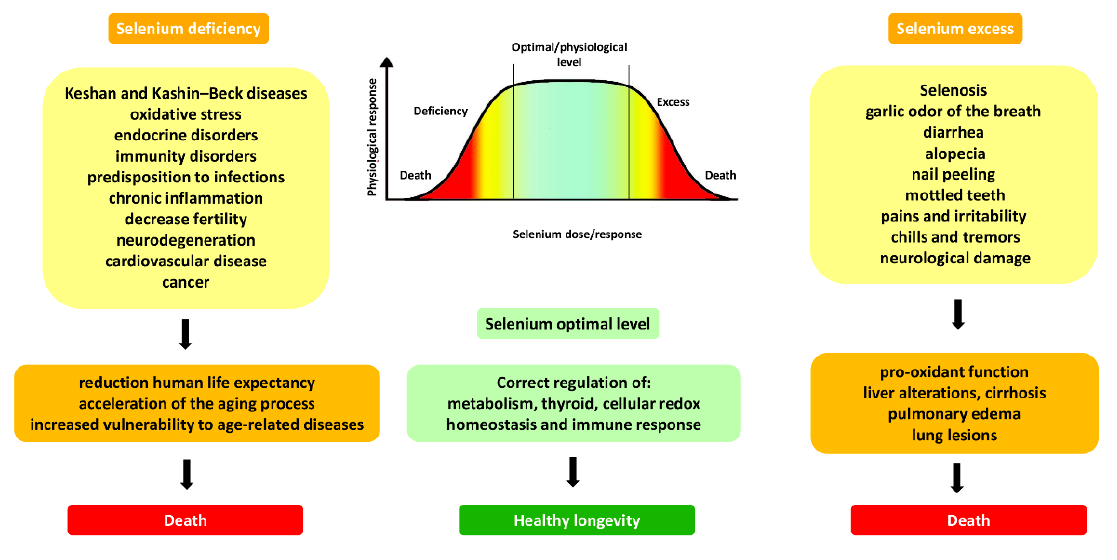
Figure 1. The main outcomes of Se deficiency and excess.